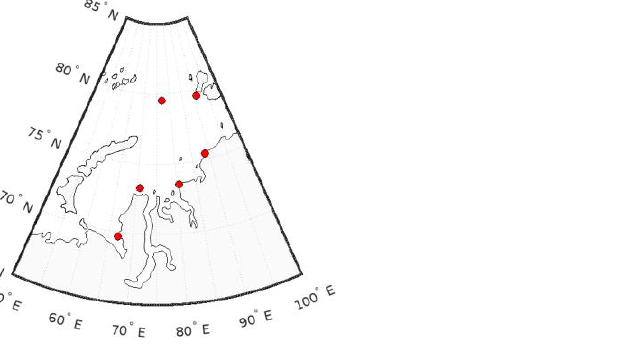
Figure 1. Location of meteorological stations where observations of air temperature and fast ice thickness were made.